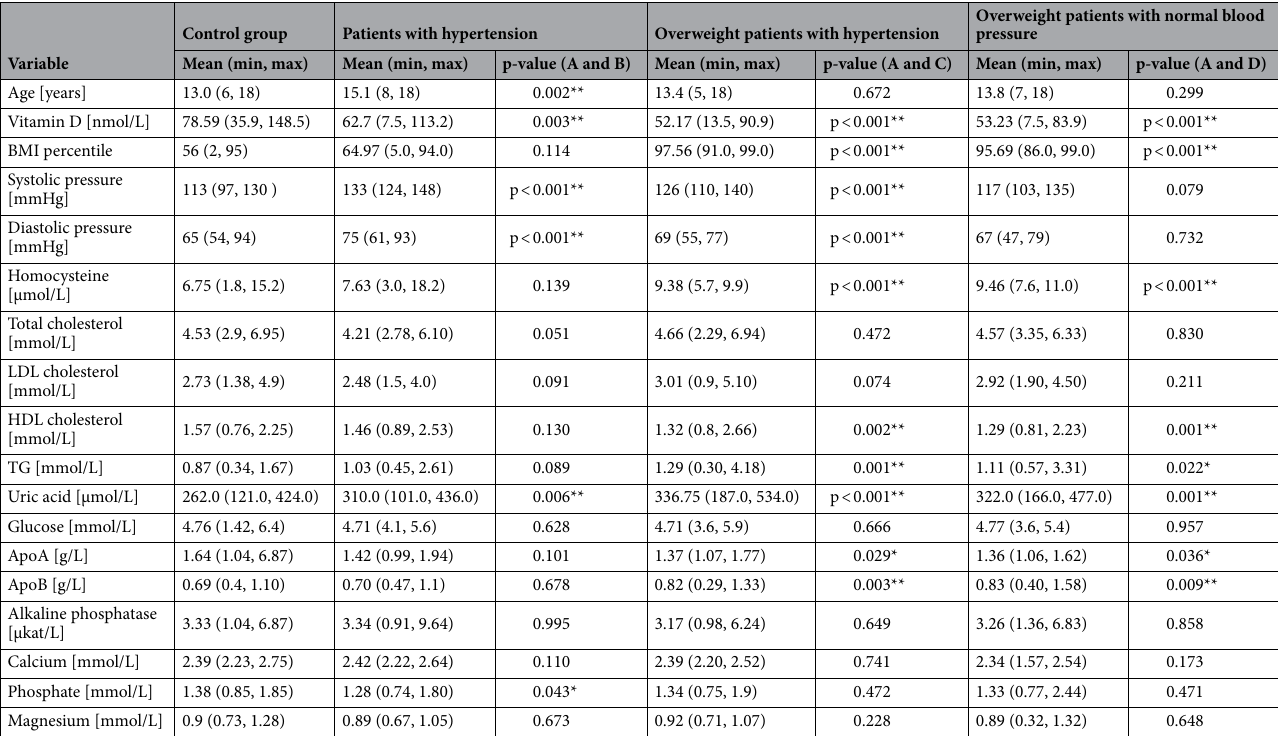
Table 2. Descriptive statistic and comparison of parameters between the groups (independent samples t-test). Control group (A), children with hypertension (B), overweight children with hypertension (C) and overweight children with normal blood pressure (D). Value p represents the comparison between the control group and all the other groups studied. Min minimal, max maximal, BMI Percentile body mass index percentile, LDL cholesterol low-density lipoprotein cholesterol, HDL cholesterol high-density lipoprotein cholesterol, TG triglycerides, ApoA apolipoprotein A1, ApoB apolipoprotein B. *p < 0.05, **p <